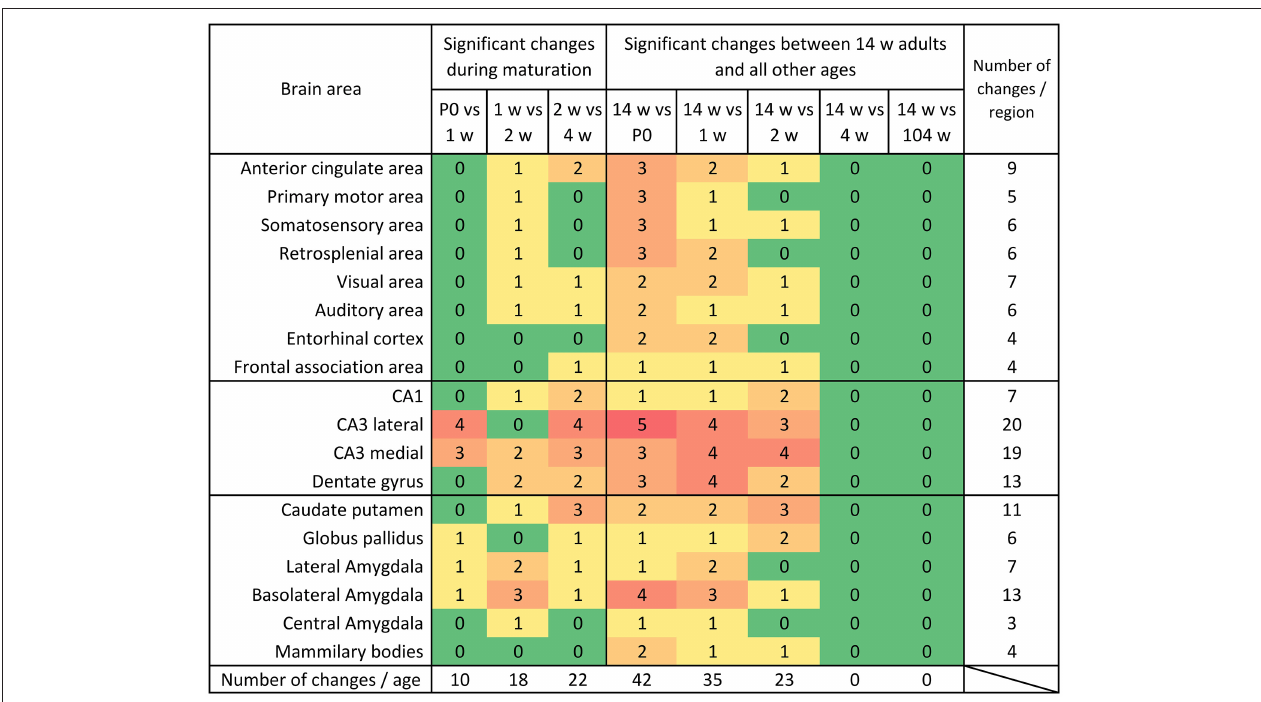
FIGURE 8 | Distribution of significant changes ( p < 0.05) of mRNA levels per region during maturation and aging. During maturation, most changes were observed between week 2 and 4. When comparing the mRNA expression levels in 14 weeks old mice to the young ages it becomes clear that the system gradually reaches its adult expression level between 2 and 4 weeks and remains remarkably stable into